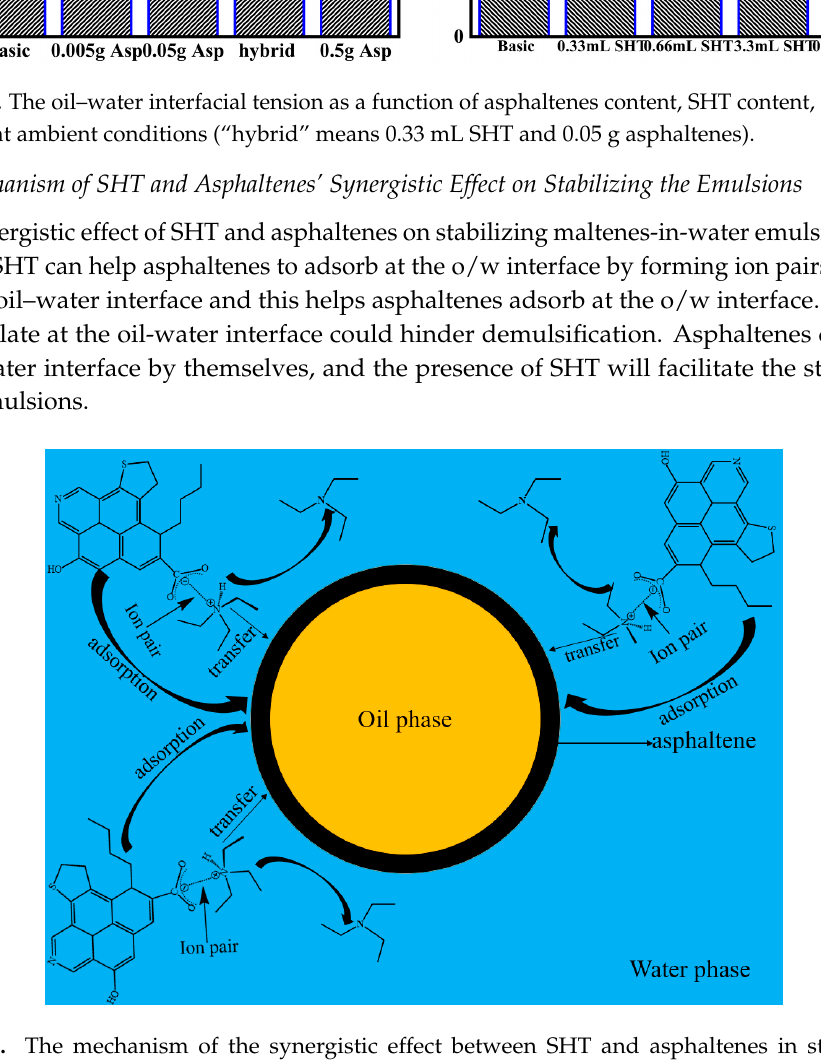
Figure 9. The mechanism of the synergistic effect between SHT and asphaltenes in stabilizing the emulsions.